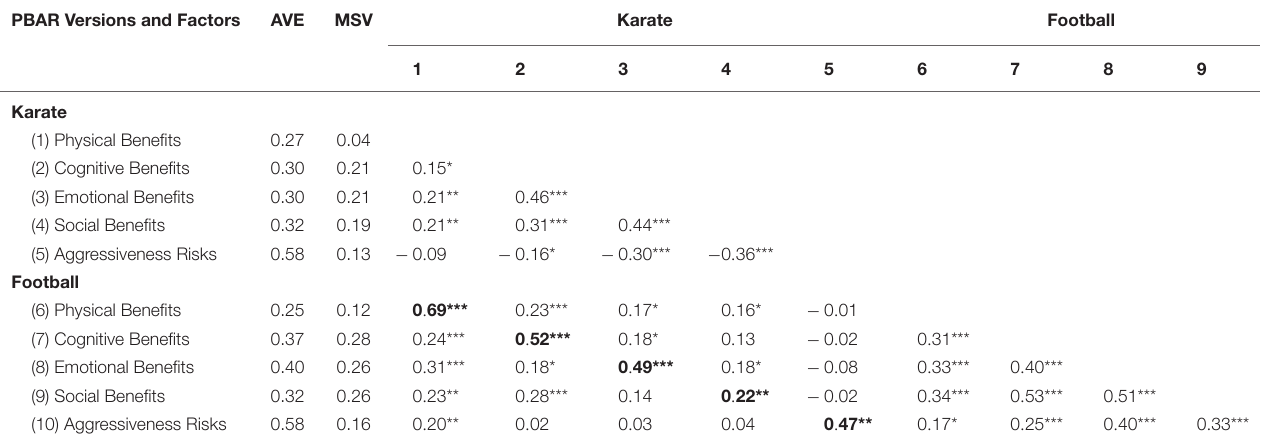
TABLE 3 | Bivariate correlations between karate and football perceived benefits and risks (same-factor correlations in bold). PBAR Versions and Factors AVE MSV Karate Football